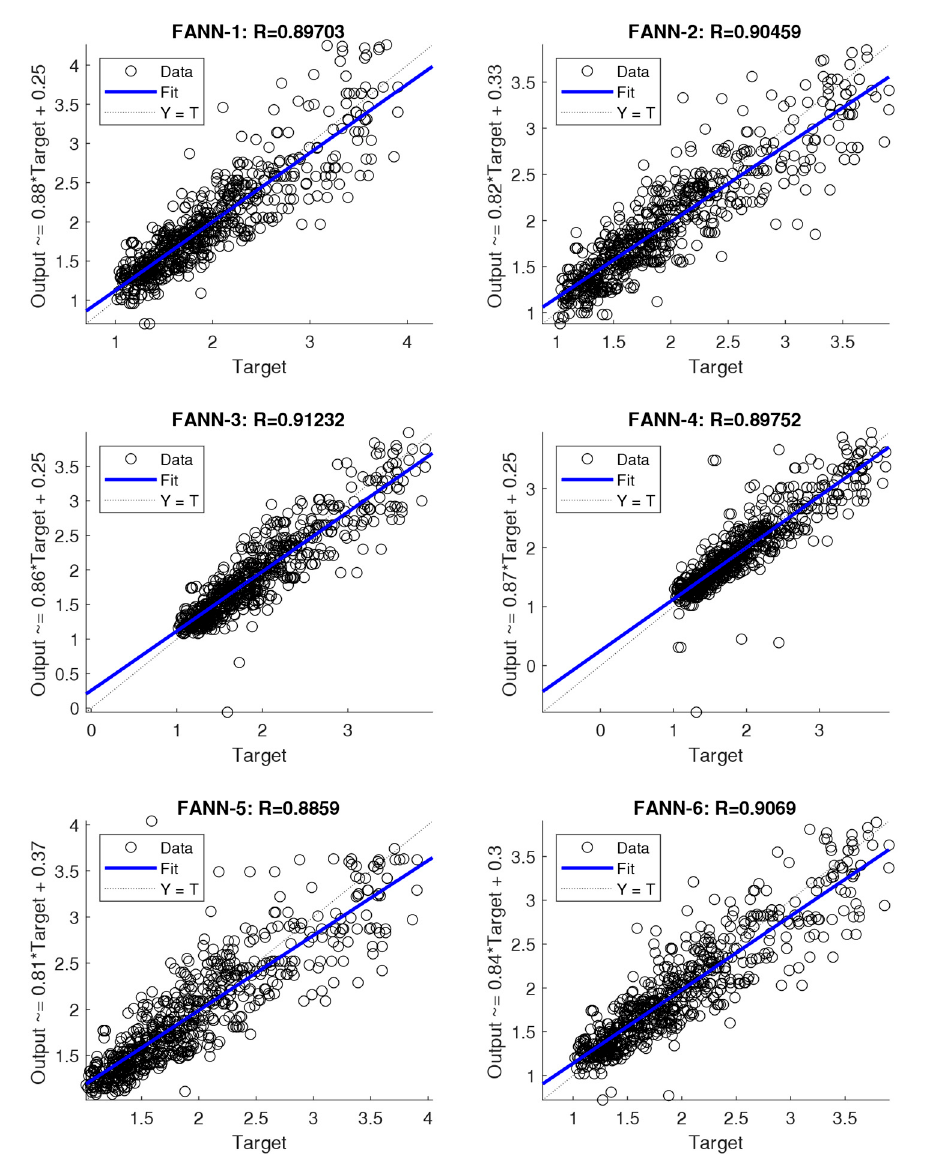
Figure 5. Predictions of the six examined ANN models for strength.